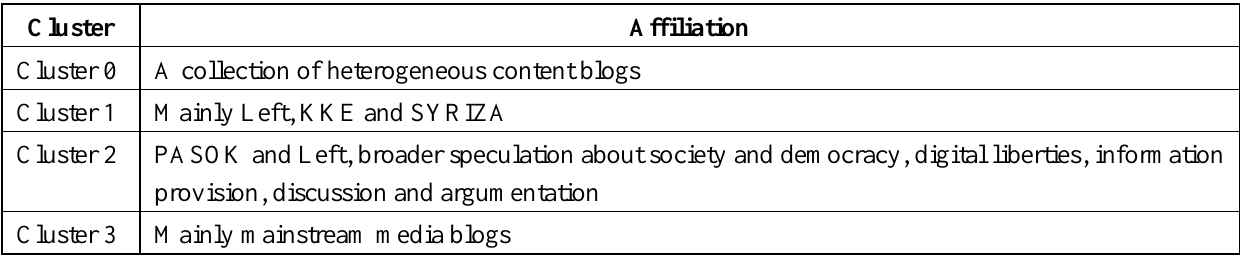
Table 2. Affiliation and properties of the clusters.